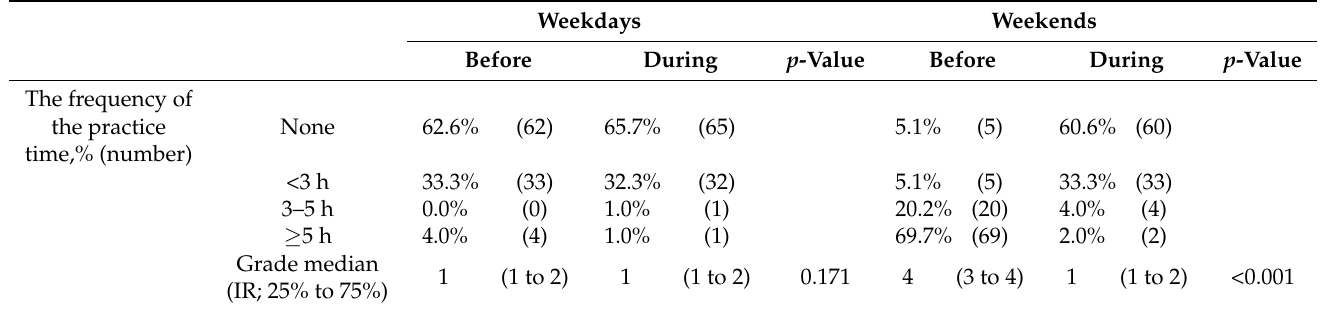
Table 2. Frequency changes in team practice time on weekdays and weekends ( n =